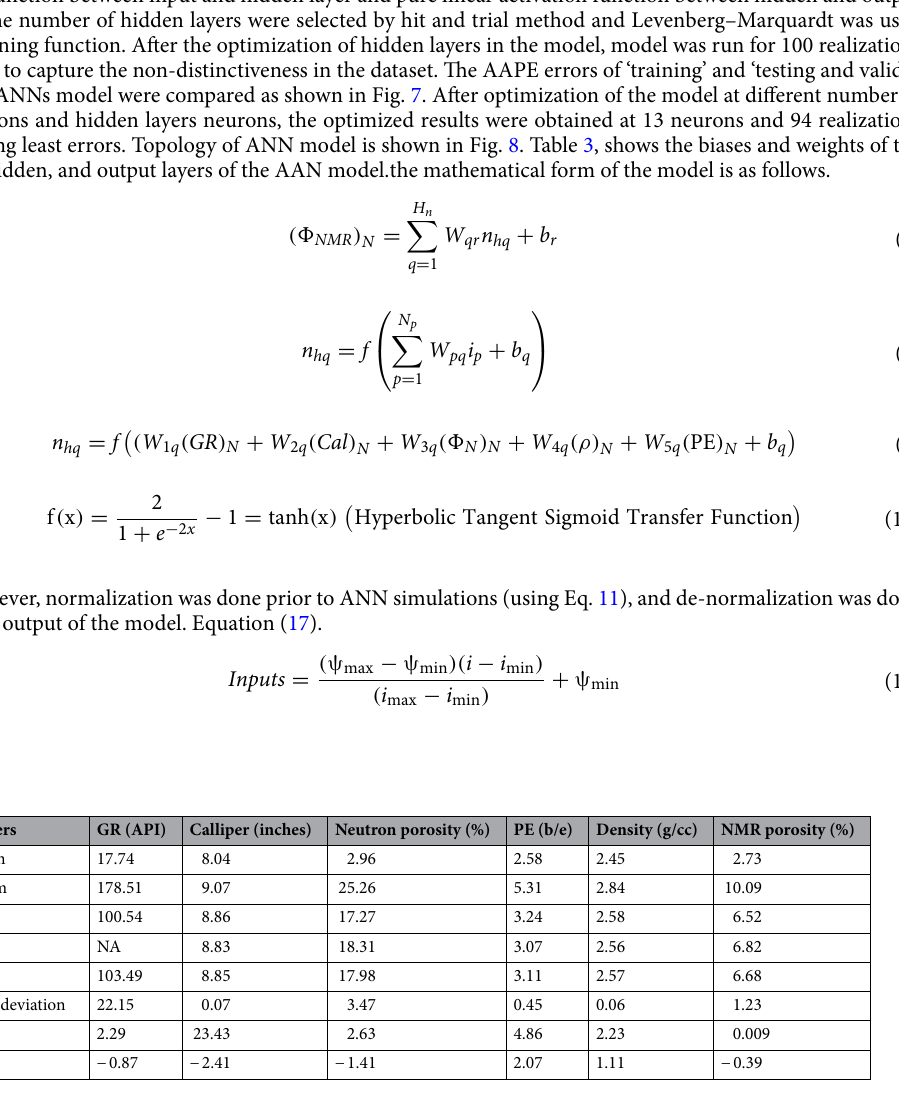
Table 2. Statistical indicators for testing